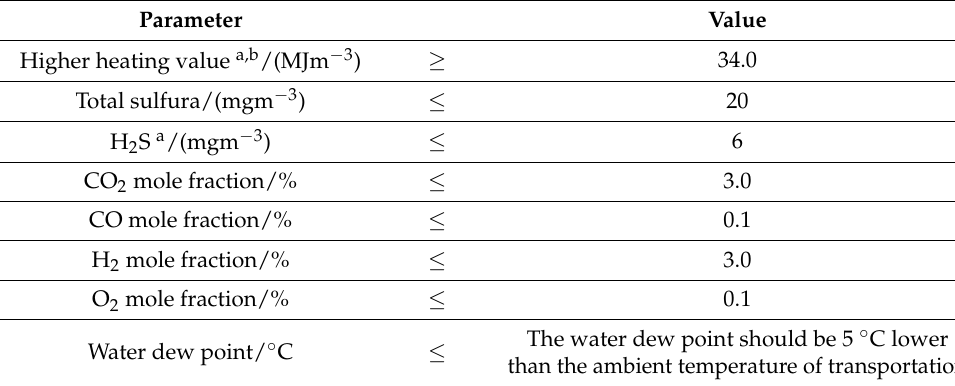
Table 2. Gas quality requirements for natural gas in long-distance pipelines. Parameter Value Higher heating value a,b /(MJm − 3 ) ≥